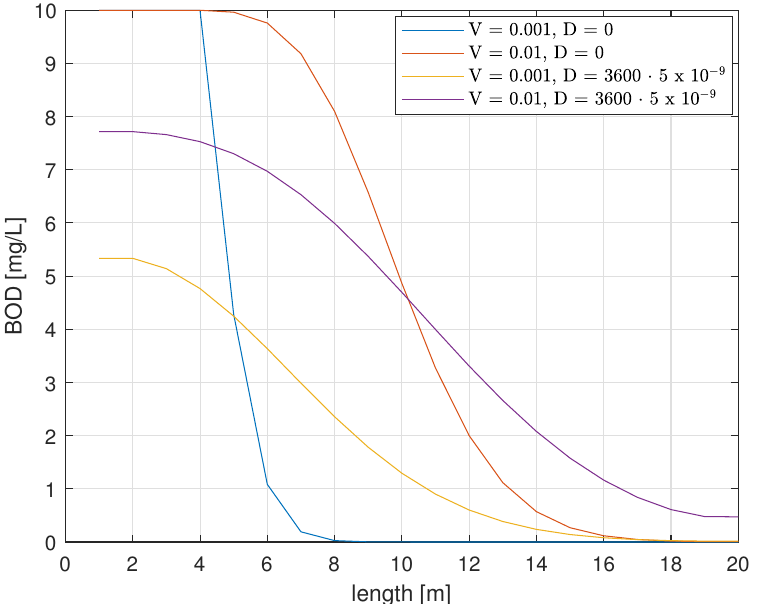
Figure 11. BOD distribution at different velocities in the same moments of time including diffusion ( D > 0 ) and excluding diffusion ( D = 0 )